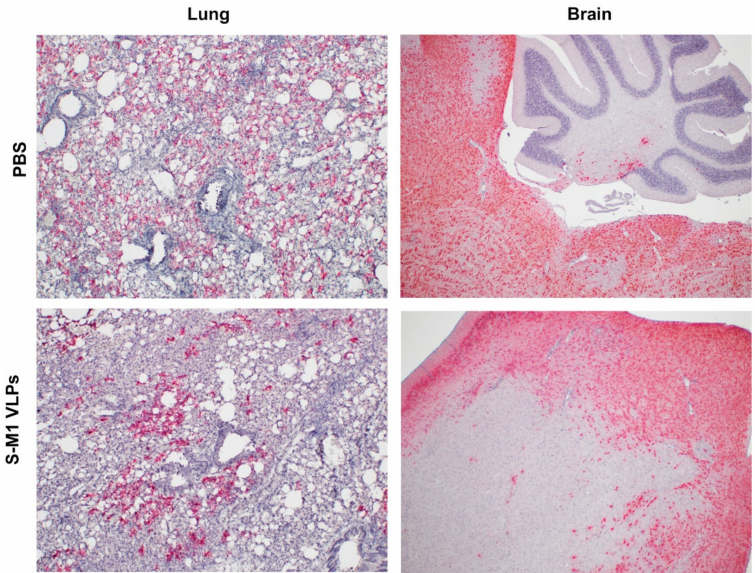
Figure 8. In situ hybridization for SARS-CoV-2 RNA in lung and brain samples. Tissue samples were collected post mortem . Formalin-fixed paraffin-embedded (FFPE) tissues of lungs and brain were performed by using the RNAscope ® in situ hybridization (ISH) assay. The V-nCoV2019-S RNAscope ® probe used is specific for the SARS-CoV-2 Wuhan-Hu-1 S gene (Genbank accession number NC_045512.2, targeting region